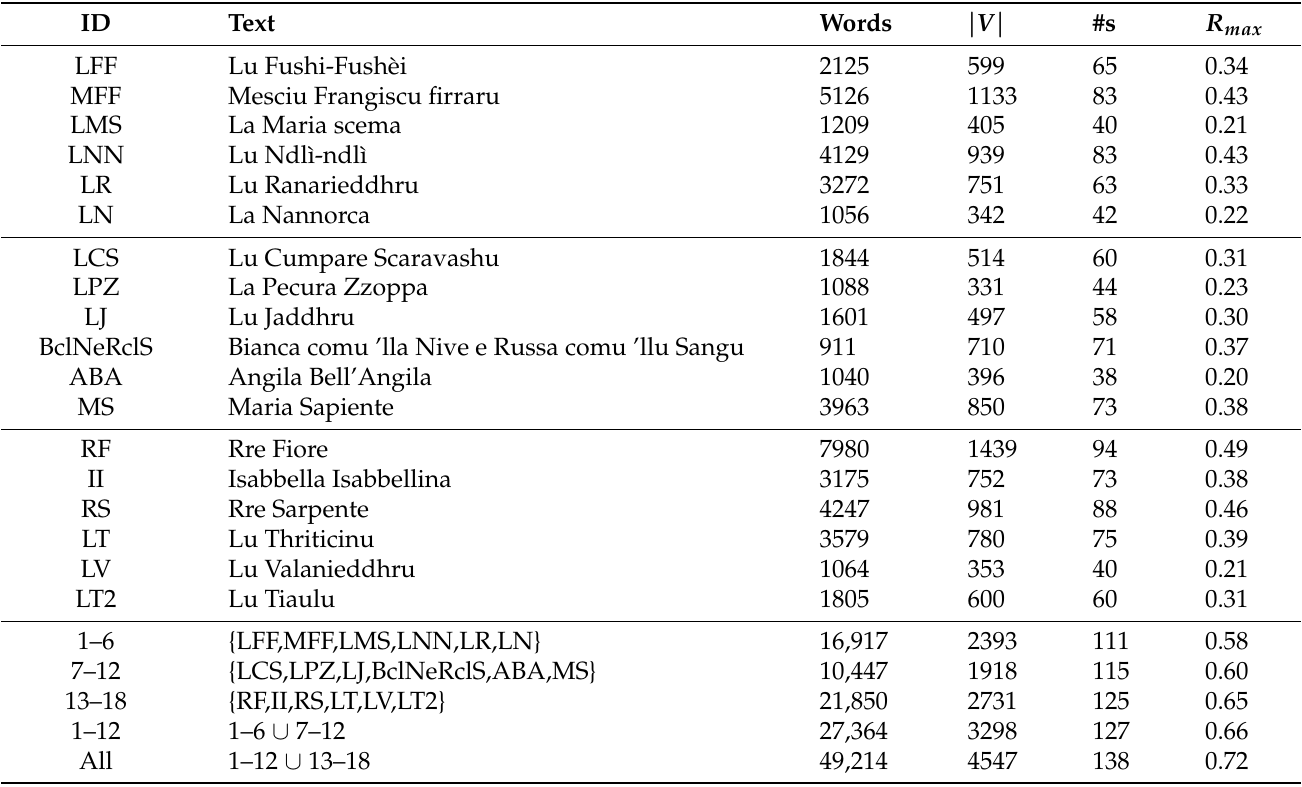
Table 3. Squinzanese